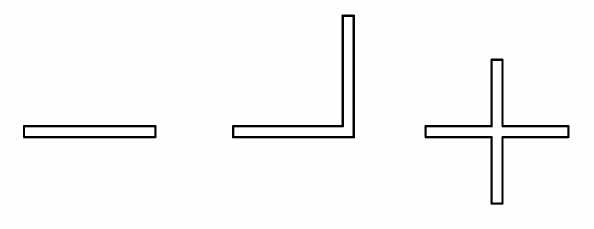
Figure 7: Shear walls constituted by thin plates converging in a single